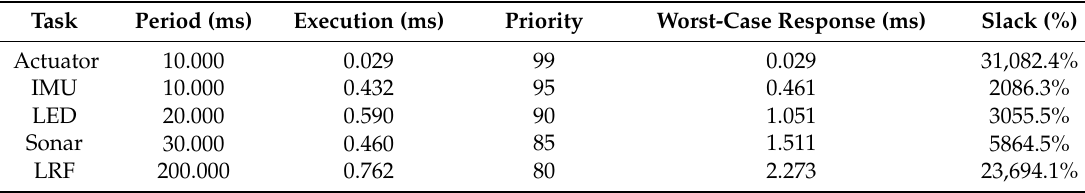
Table 6. Schedulability analysis for the navigation of M4K using MAST